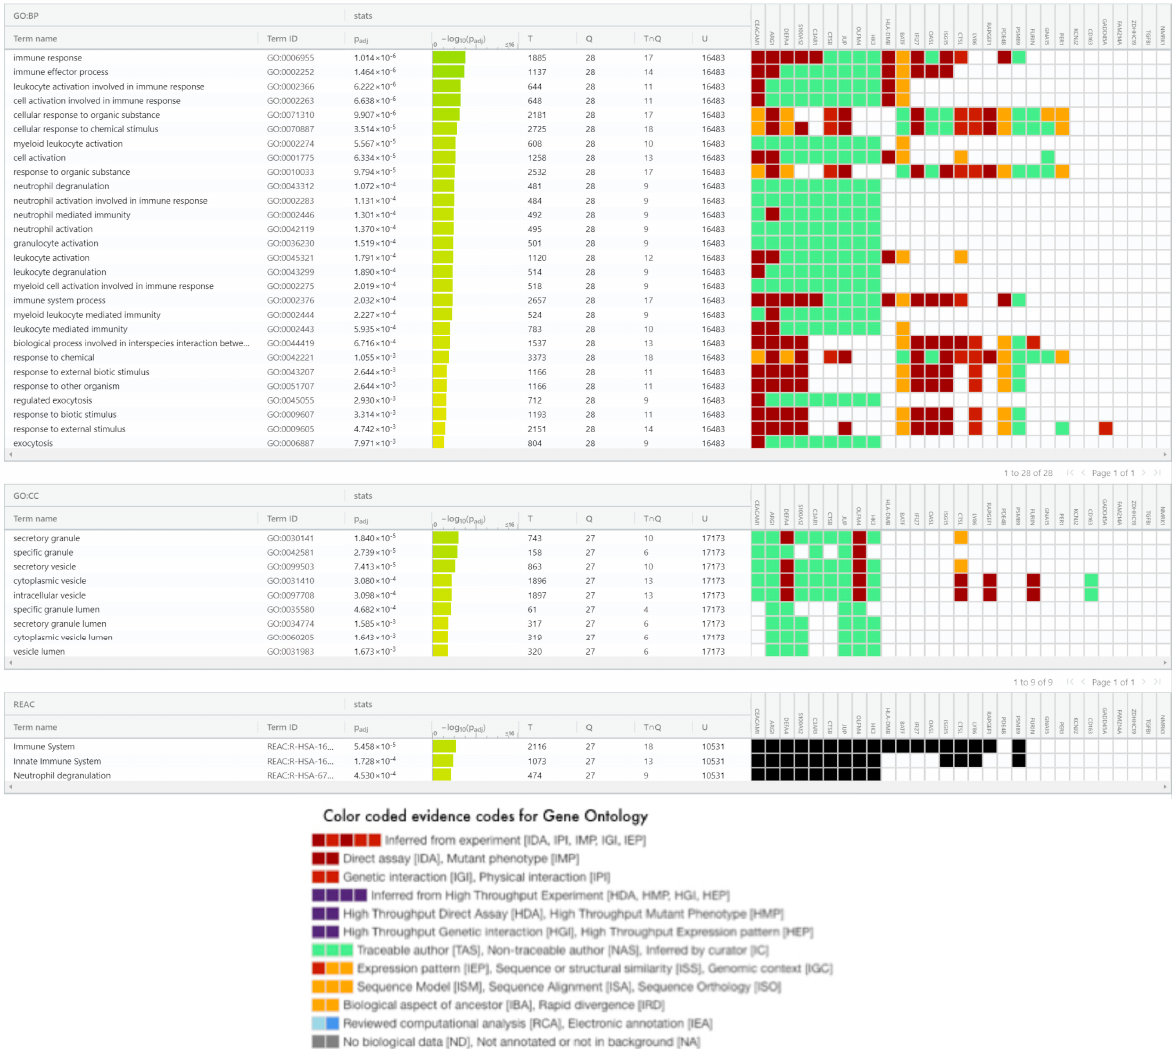
Figure 2. Significant biological process (28) and cellular compartment (9) terms in gene ontology, and reactome (3) terms found for 29 InSep genes. Terms in GO BP, GO CC, and Reactome are ordered respectively by their adjusted p -values in the enrichment analysis using g:Profler [25,26,81]. Also shown are members of each term found in the 29 genes with color coded evidence code legend below the table.